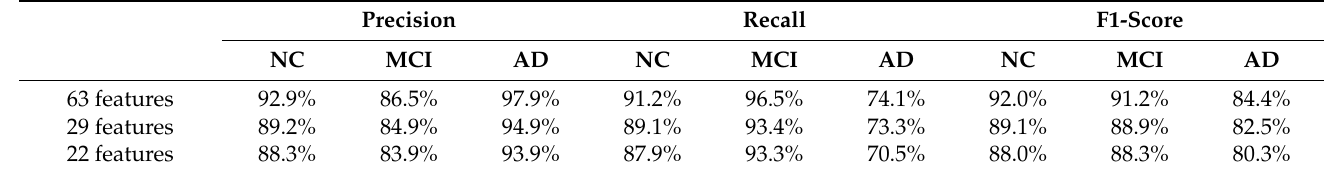
Table 3. Precision, Recall, and F1-score for RF